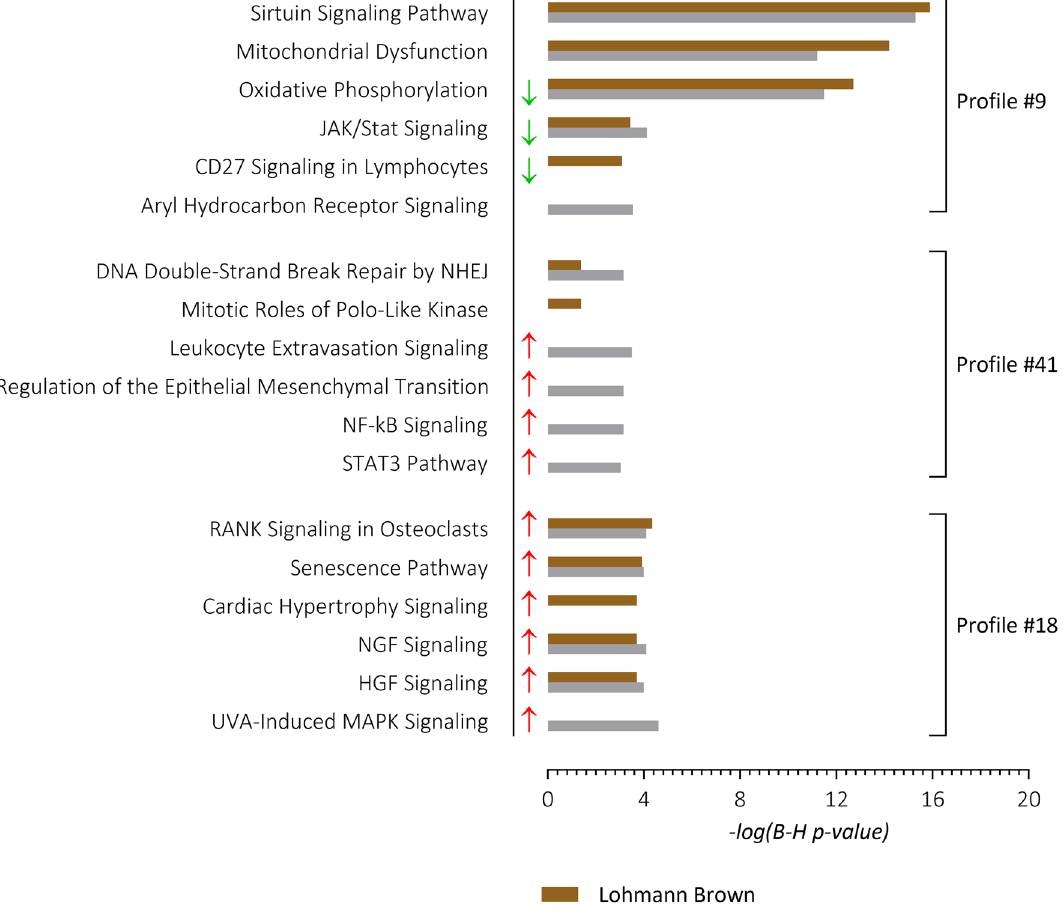
Figure 4. Top 5 canonical pathways predicted from selected STEM profiles in LB and LSL laying hens. Analyses comprise profiles #9 (consistently lower mRNA abundances with advancing production periods), #41 (consistently higher mRNA abundances with advancing production periods), and #18 (sustained increase in mRNA abundances from onset of laying). Arrows indicate significantly activated (red) and inhibited (green) pathways over the time course from week 10 to week 60 referring to the z-score. NHEJ—Non-homologous end